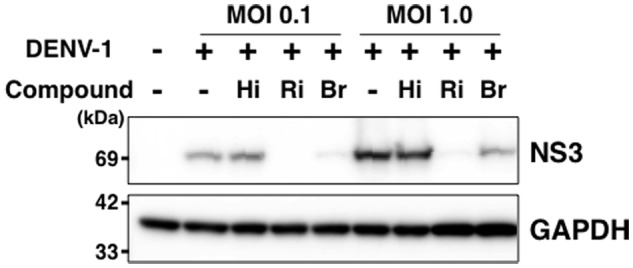
Hirsutine does not inhibit viral genome RNA replication. A549 cells were infected with DENV-1 at a MOI of 0.1 and 1.0 in the presence of 10 μM hirsutine (Hi), 100 μM ribavirin (Ri), or 10 μM bromocriptine (Br). Cell lysate was collected 18 h post-infection, and DENV-NS3 (top) and GAPDH (bottom) protein expression levels were assessed by Western blot.